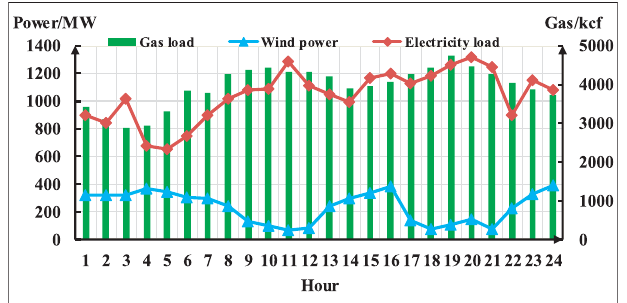
FIGURE 3 | Forecasting wind power, electricity load and gas load.